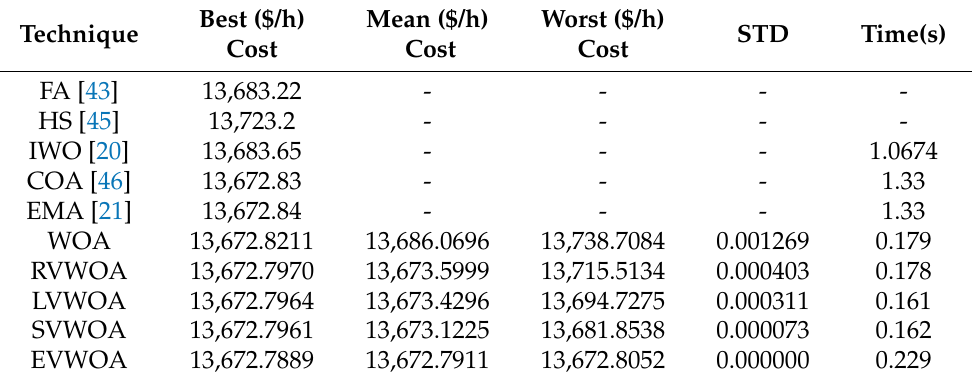
Table 7. Comparison of quality solution for Case Study 2.